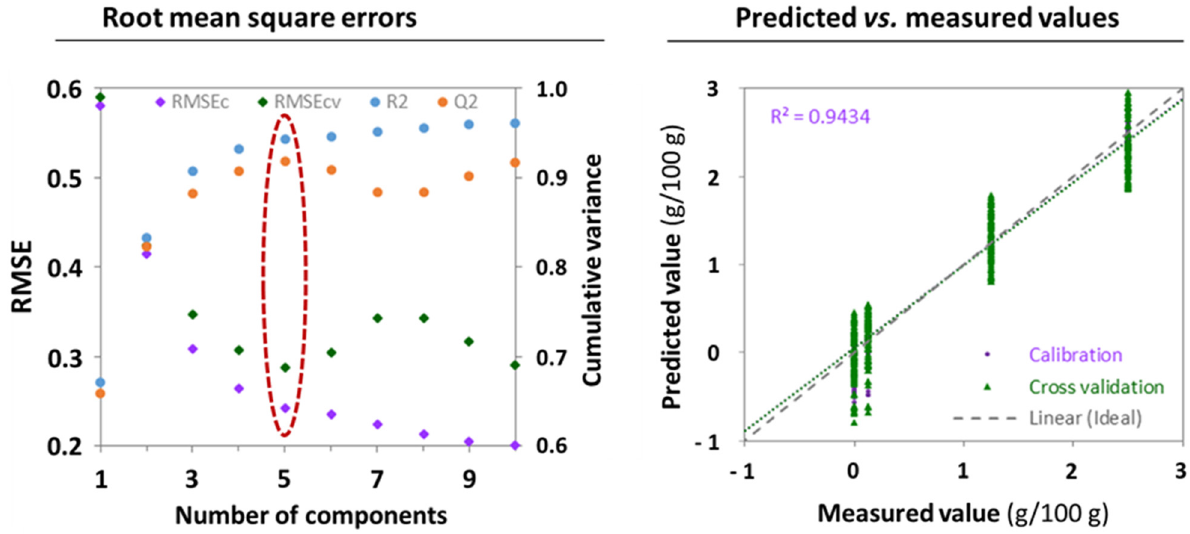
Figure 5. Orthogonal partial least squares regression model for ammonium sulfate in wet-blended skimmed milk powders from spectra acquired with the device D : Left panel: Root mean square errors (calibration and cross-validation) and cumulative variances (explained and predicted) as a function of model size (number of total components). Right panel: predicted versus measured values on cross-validation (model fitness).